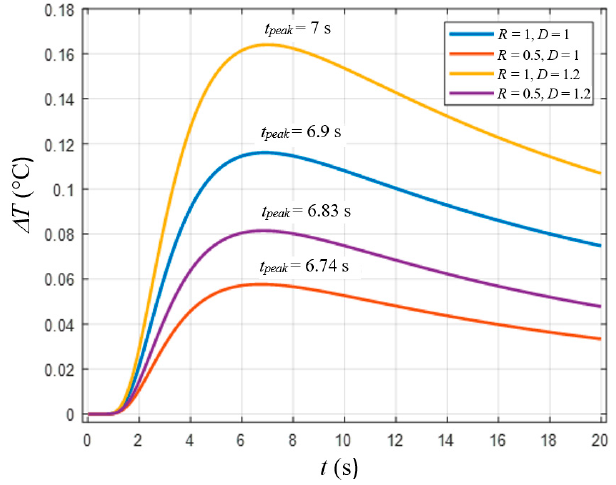
Figure 1. Differential temperature signal ( ∆ T ) curves vs. time for different values of thermal reflection coefficient R and defect diameter D (obtained by Equation (4), Q 0 = 10,000 J/m 2 , e = 538 W · s 1/2 · m − 2 · K − 1 , α = 0.58 · 10 − 7 m 2 /s, d = 1 mm, m = 1, n =